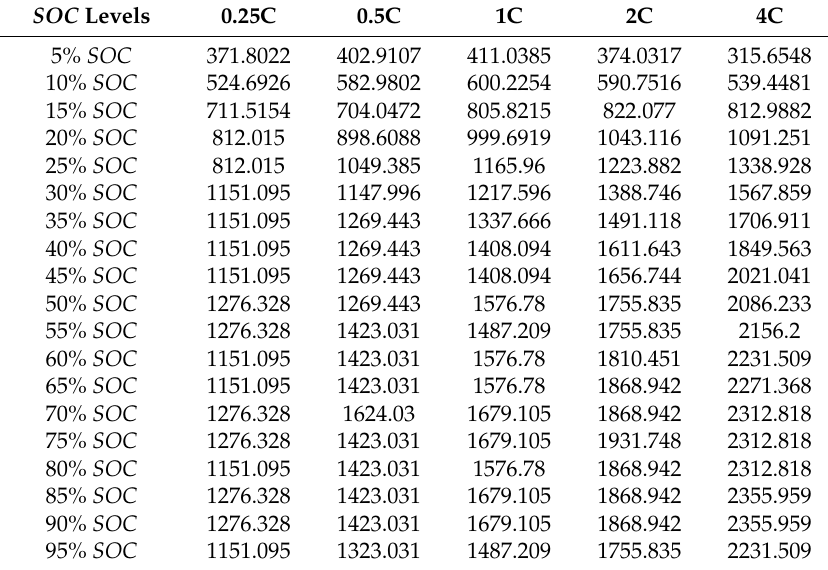
Table 6. 2-D lookup table for the determination of C 1 .